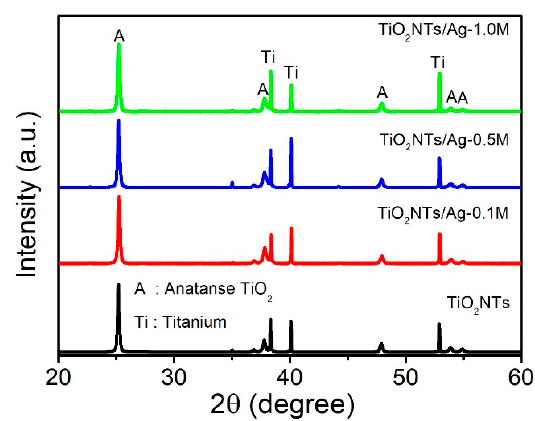
Figure 2. XRD patterns of TiO 2 NTs and TiO 2 NTs/Ag-0.1 M, -0.5 M and -1.0 M.